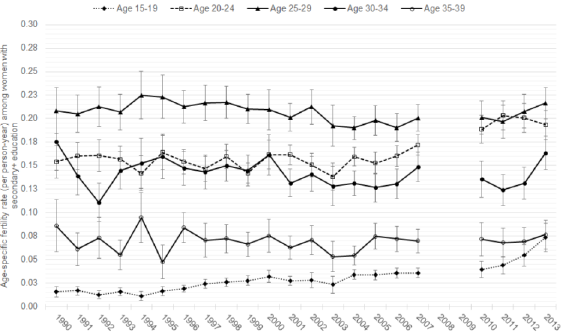
Fig 5. Annual ASFRs for women under age 40 with secondary or higher education,